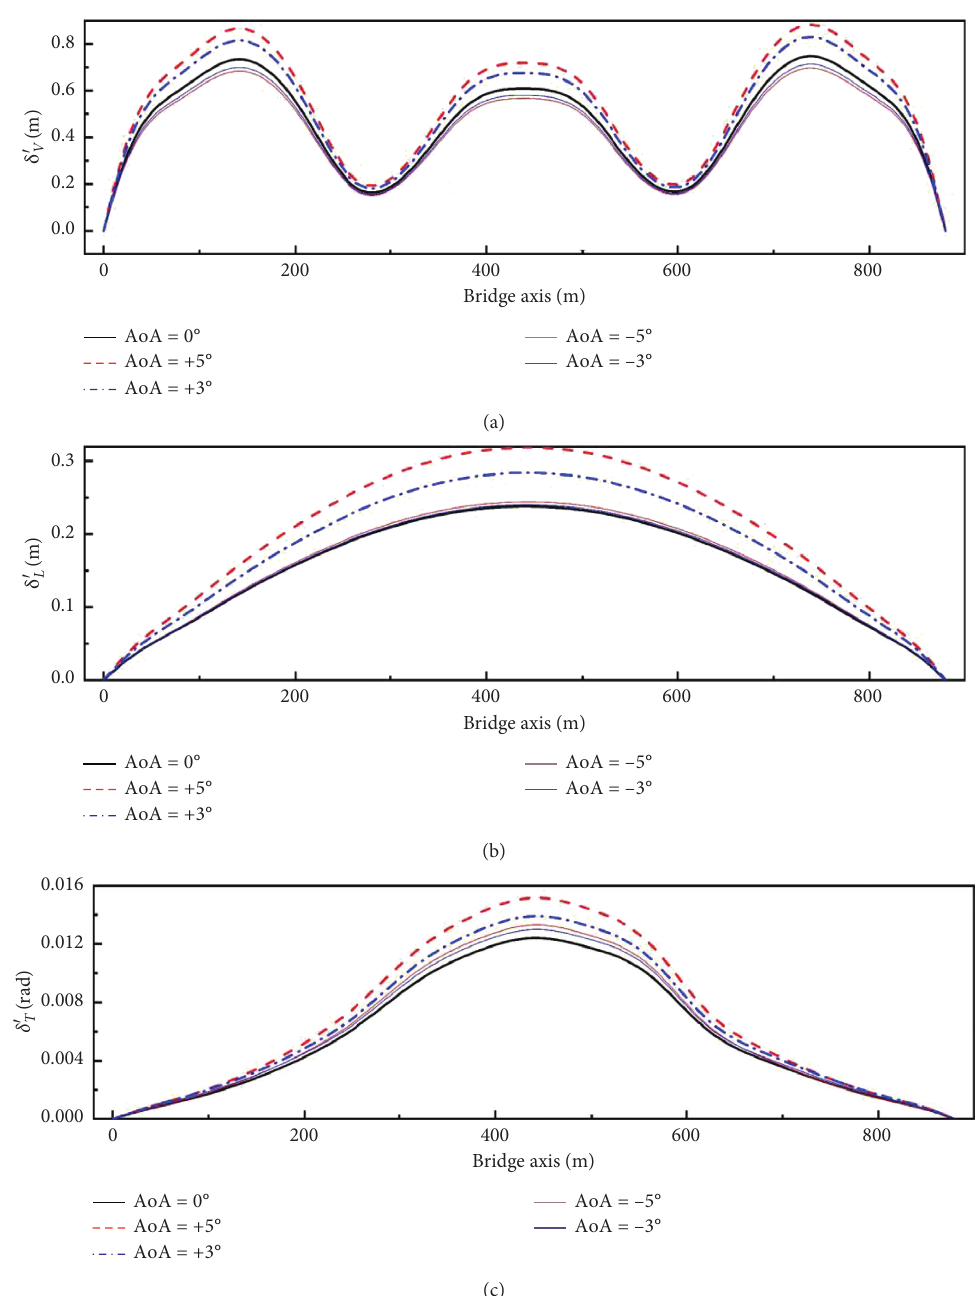
Figure 17: Effects of AoA on the buffeting responses (Case 1): (a) RMS vertical displacement δ torsional displacement δ T ′